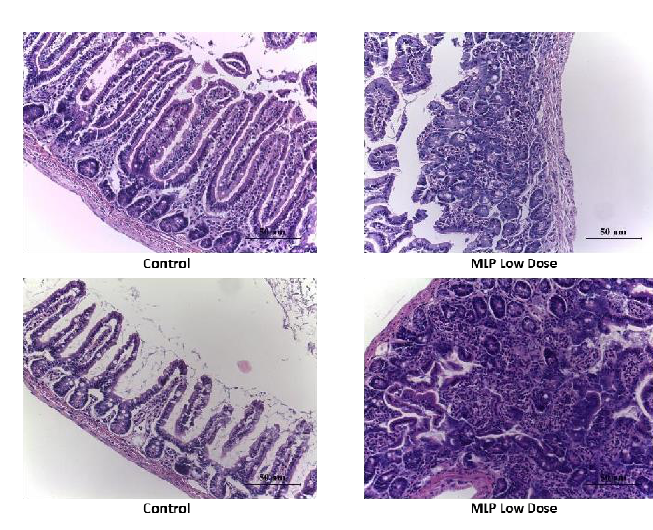
Figure 5. ( A ) Level of Th2 (IL-4), ( B ) Th9 (IL-9), and ( C ) Th17 (IL-17A)in MLP-sensitized mice splenocyte supernatant by ELISA. Significant difference (** p < 0.01; n ≥ 5) compared with the control group.